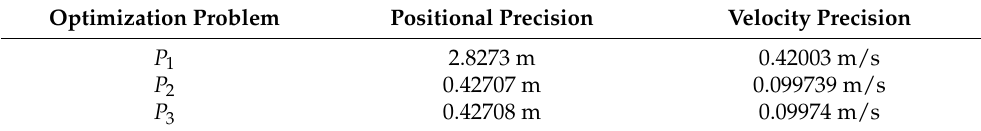
Table 2. Comparison of landing